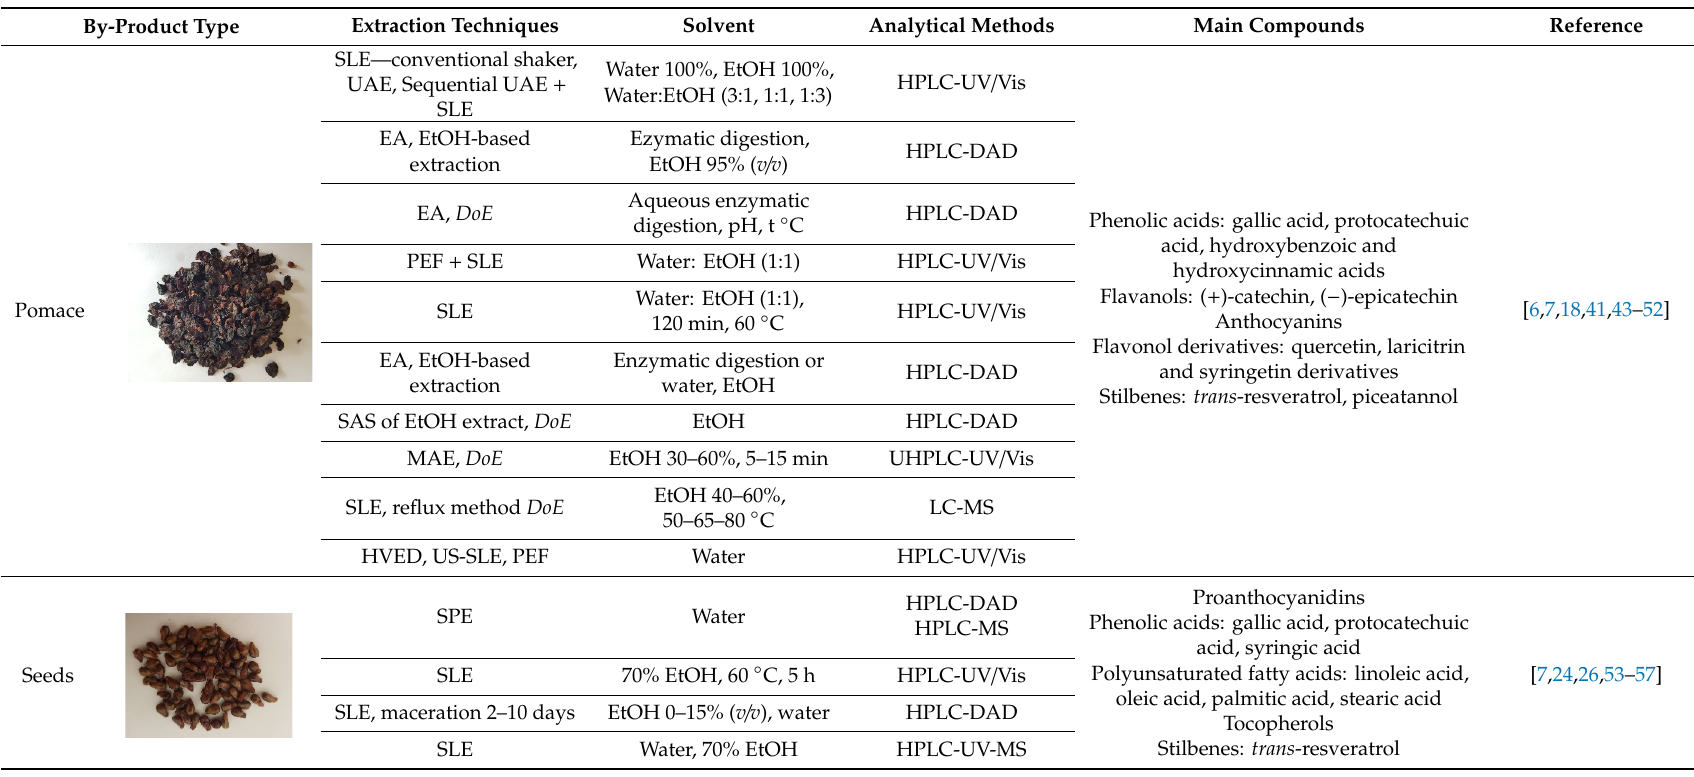
Table 1. Overview of main bioactive compounds, extraction techniques and solvents of phenolic compounds (PhCs) from V. vinifera by-products. By-Product